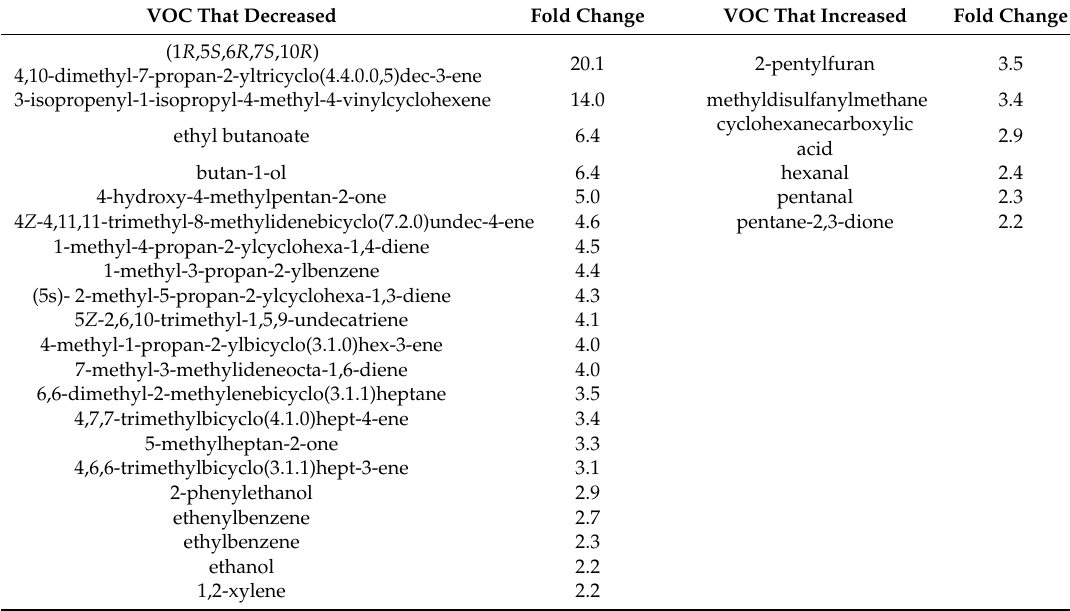
Table 4. Summary of fold change data in Group 2.